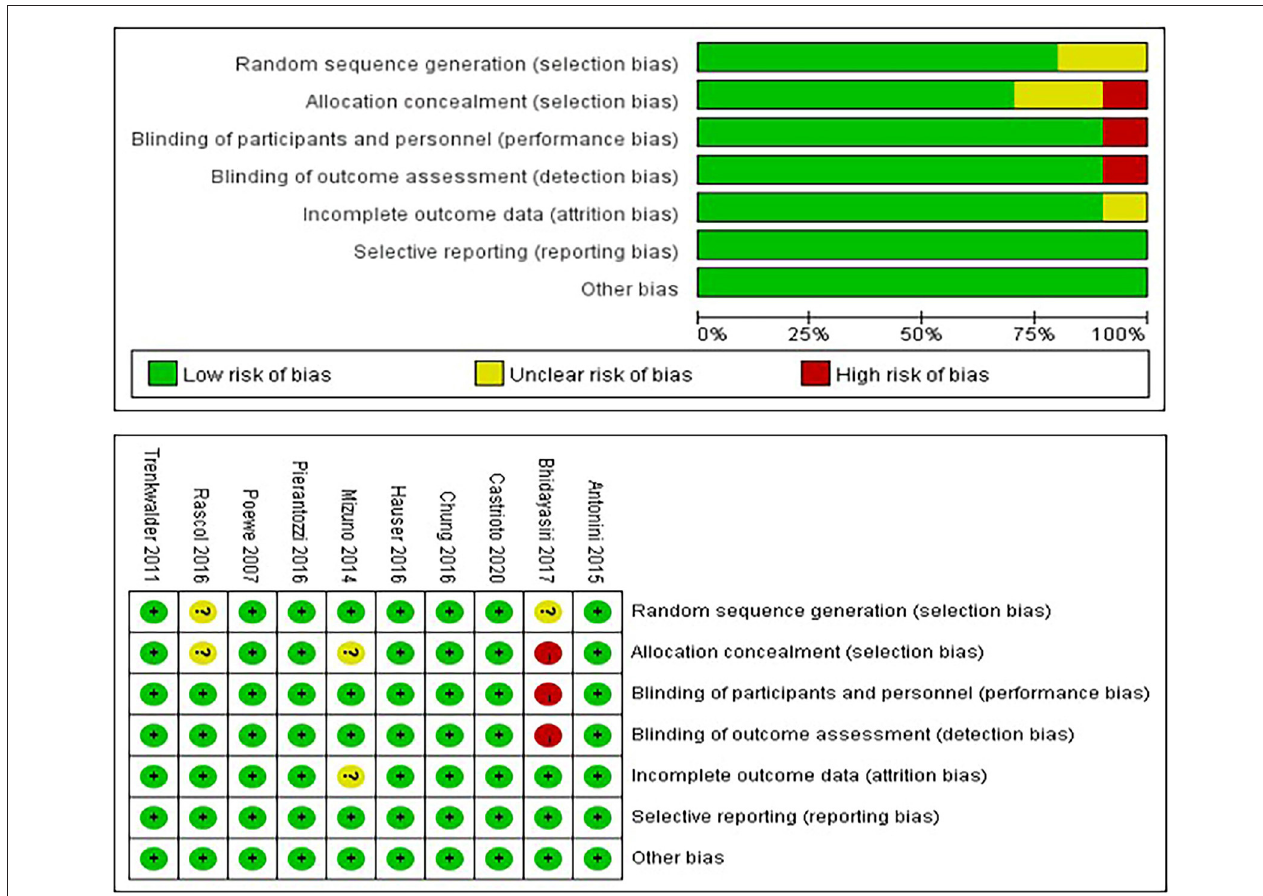
FIGURE 2 | Quality assessment of the included